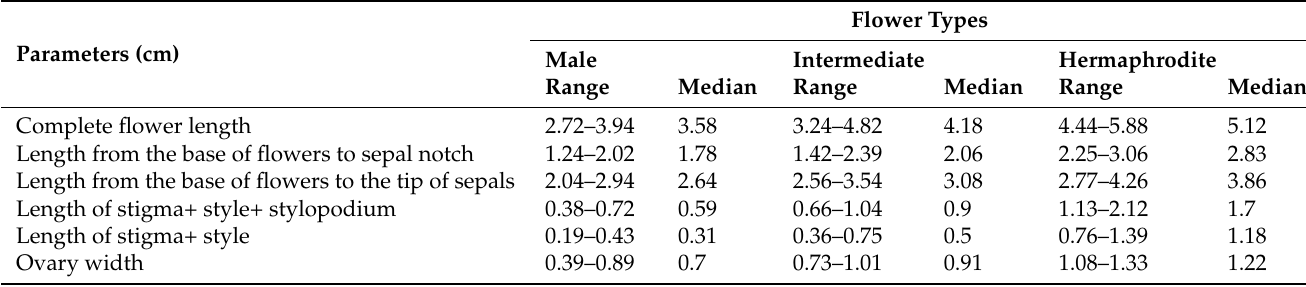
Figure 1. Flower sex ratio in different pomegranate genotypes. Stacked columns represent flower sex percentage, with differences in color corresponding to three flower sex types. Table 1. Floral morphological parameters of pomegranate